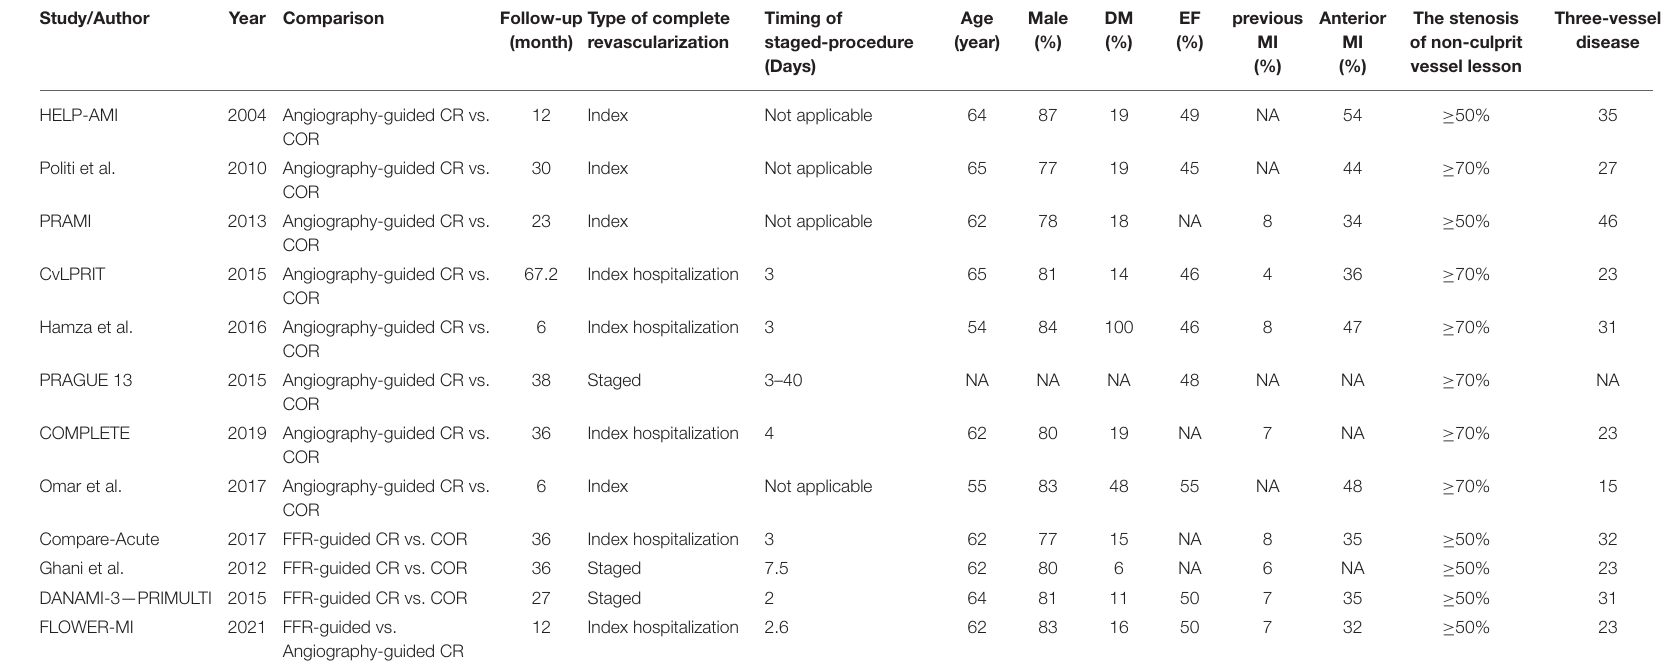
TABLE 1 | The characteristic of included